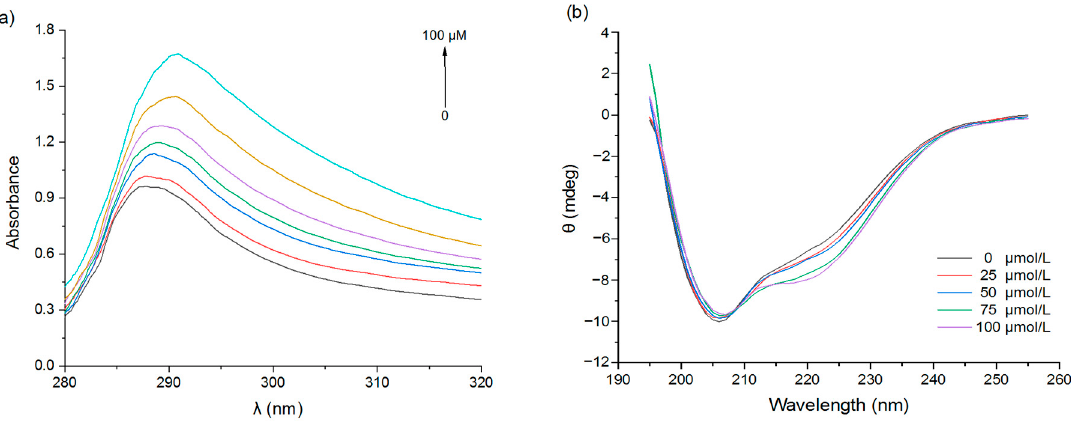
Figure 3. UV absorption spectra ( a ) and CD spectra ( b ) of PPI with different EGCG concentrations.